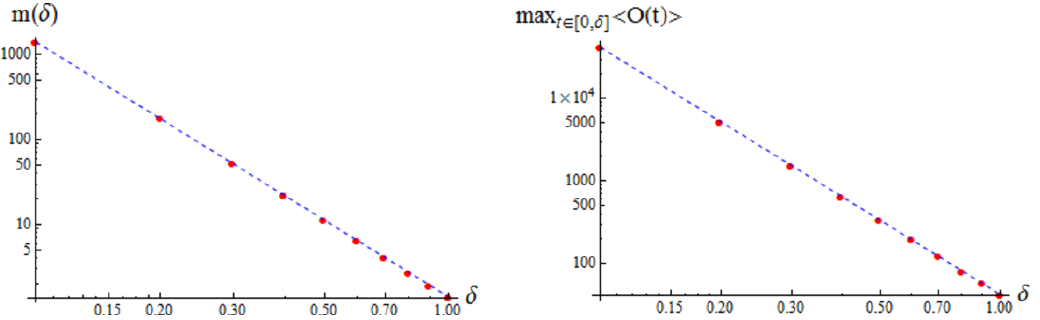
Figure 11 . Left: log-log plot of m ( (cid:14) ) (red dots) and the (cid:12)tting curve m ( (cid:14) ) / (cid:14) (cid:0) 3 (blue dashed) for a quench pro(cid:12)le given by the r.h.s. of (5.2) applied to (cid:30) 0 ( t ). Right: log-log plot of max (red dots) and the (cid:12)tting curve max hO (cid:30) ( t ) i / (cid:14) (cid:0) 3 (blue dashed) for the same quench process t 2 [0 ;(cid:14) ] as in the left